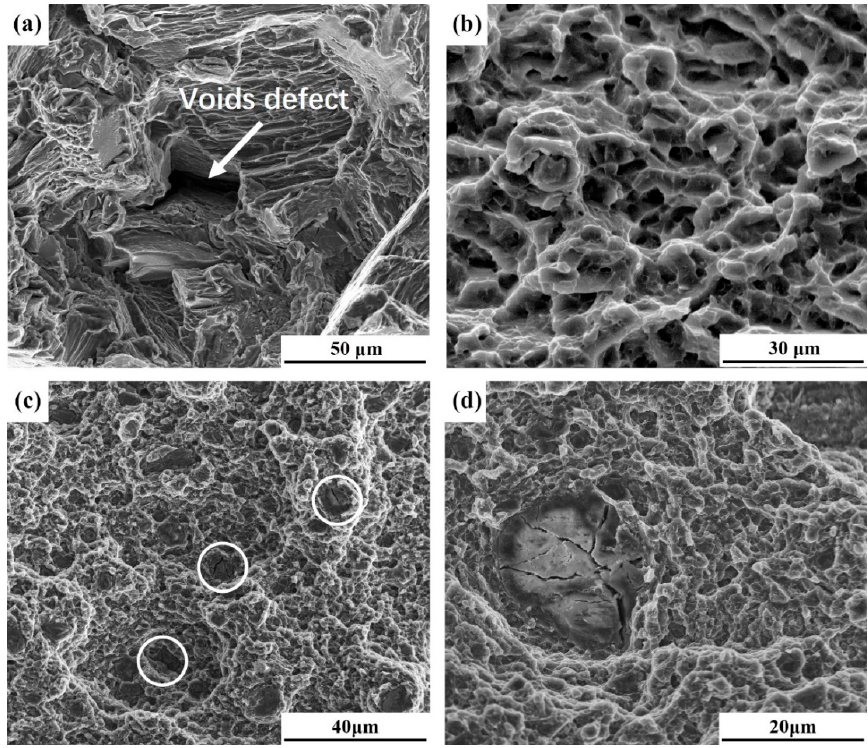
Figure 8. Fractographic images of ( a ) BM, ( b ) FSP-WE43, and ( c ) and ( d ) WE43/nHA specimens.